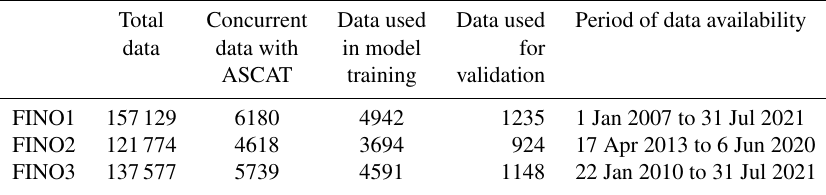
Table 3. Total number of samples used in the random forest model training from each FINO mast at 30min averages. Note that the “Data used in model training” are 80% of that of the concurrent data, whereas the “Data used for validation” are